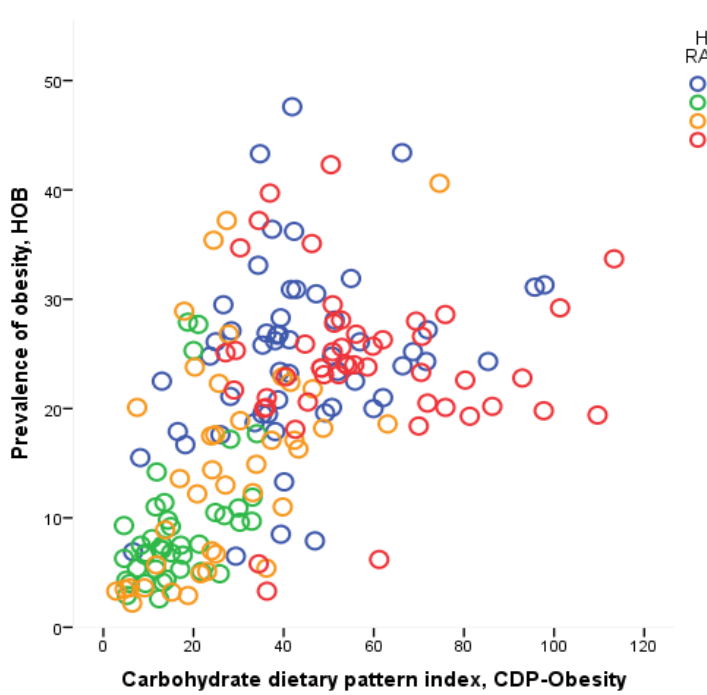
Figure 1. Carbohydrate dietary pattern (CDP) index and the rate of prevalence of obesity.